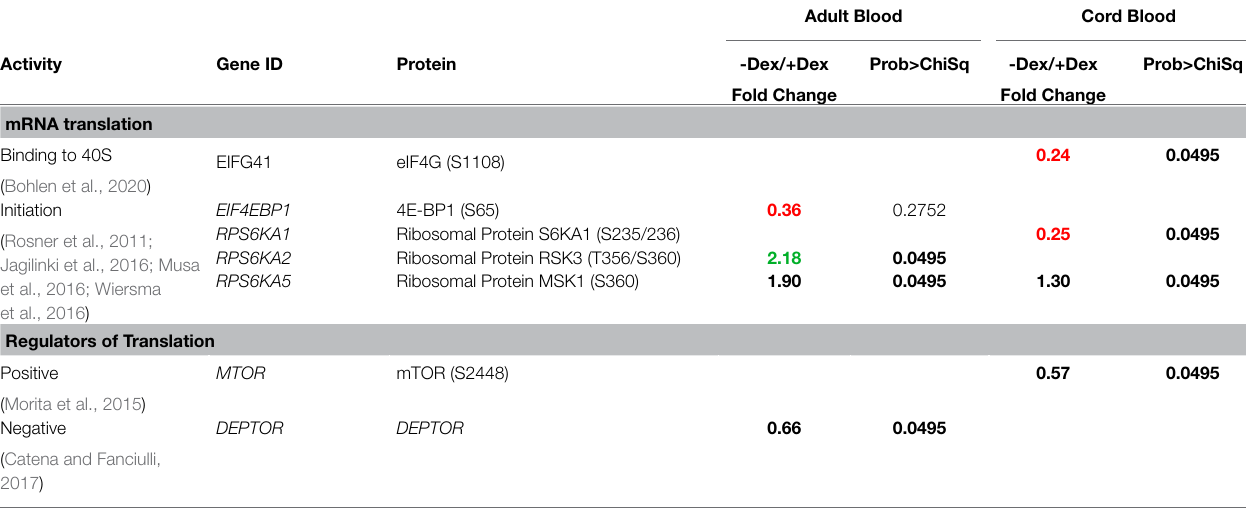
TABLE 5 | Ribosomal signature in erythroblasts obtained with and without Dex from Adult Blood and Cord